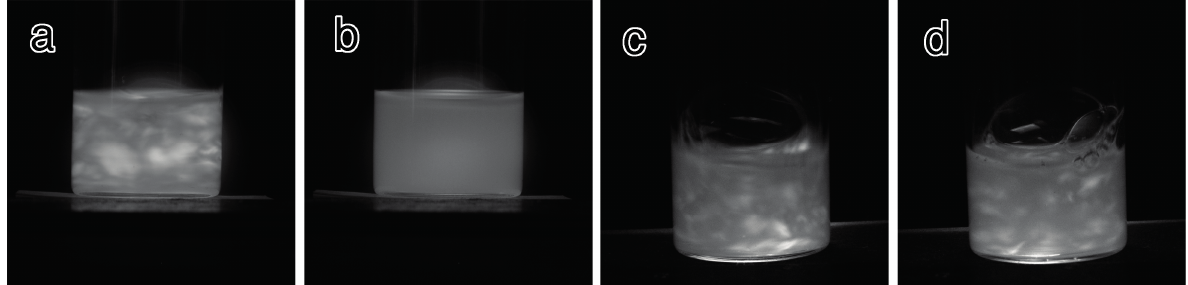
Figure 1. Appearances of the nanowhisker suspensions shaken between crossed polarizers.